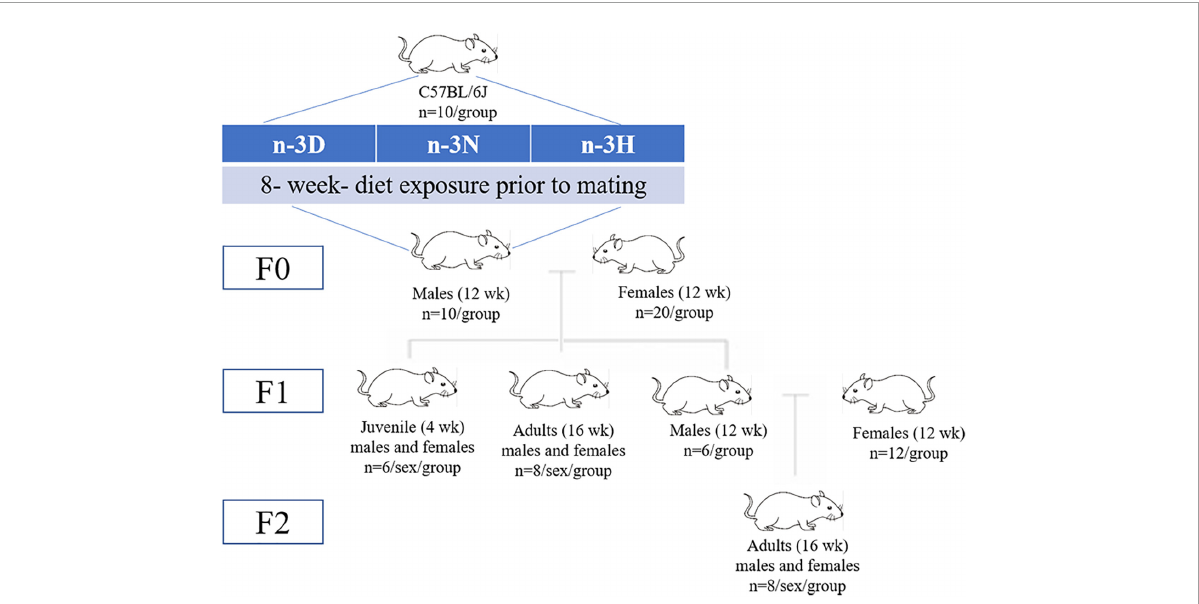
FIGURE1 Schematic overview of the study design. Founder (F0) male mice were allocated either an n-3 polyunsaturated fatty acid (n-3 PUFA)-deficient (n-3 D) diet, a diet with normal n-3 PUFA content (n-3 N with an n-6: n-3 PUFA ratio at 4.3:1), or a diet with a high n-3 PUFA content (n-3 H with an n-6: n-3 PUFA ratio of 1.5:1) for 8 weeks. After 8 weeks of feeding intervention, the F0 mice were mated with 12-week-old virgin female normal-weight naturally cycling C57BL/6J mice (1 male for 2 females per cage), to produce F1 offspring. For production of the F2